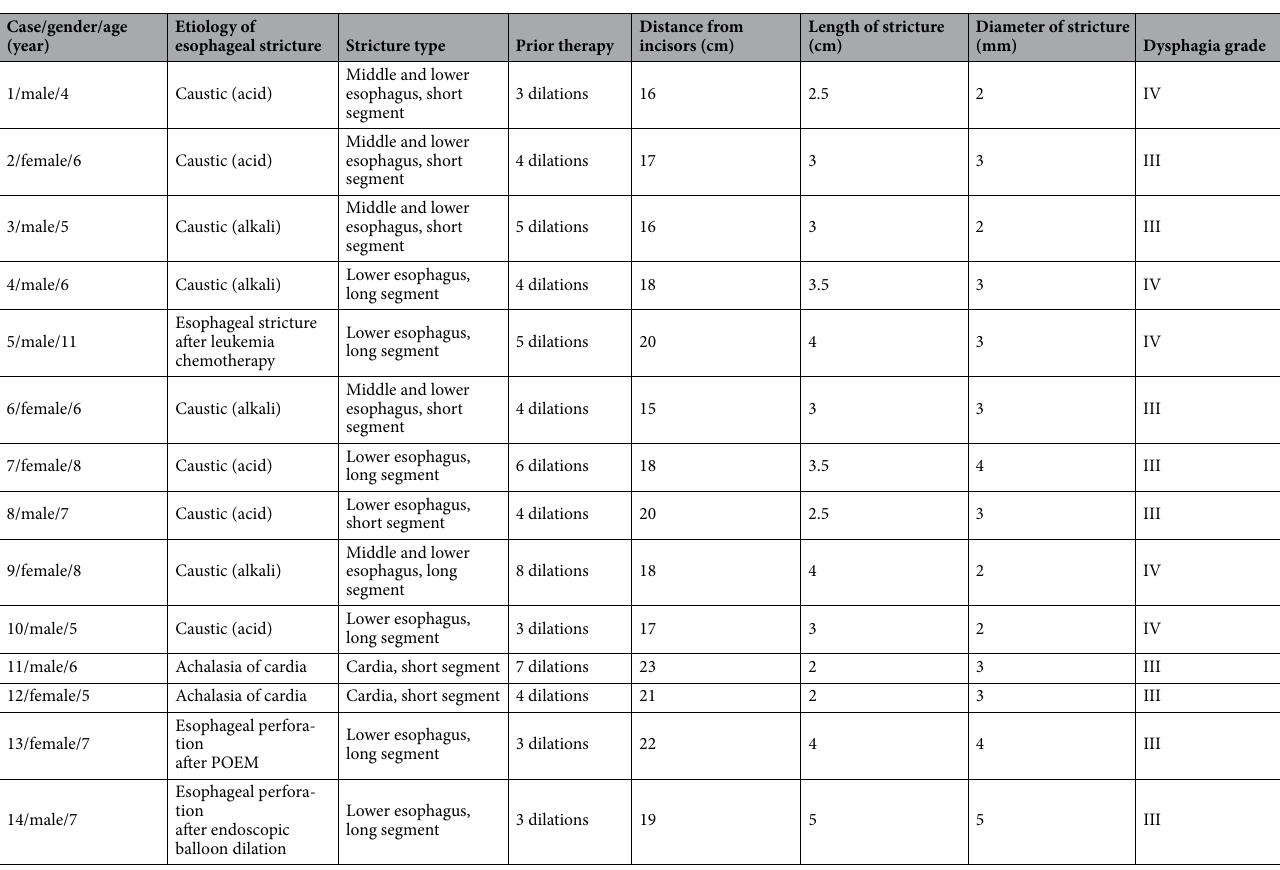
Table 1. Clinical characteristics of 14 pediatric patients with RBESs. RBESs, refractory benign esophageal strictures.